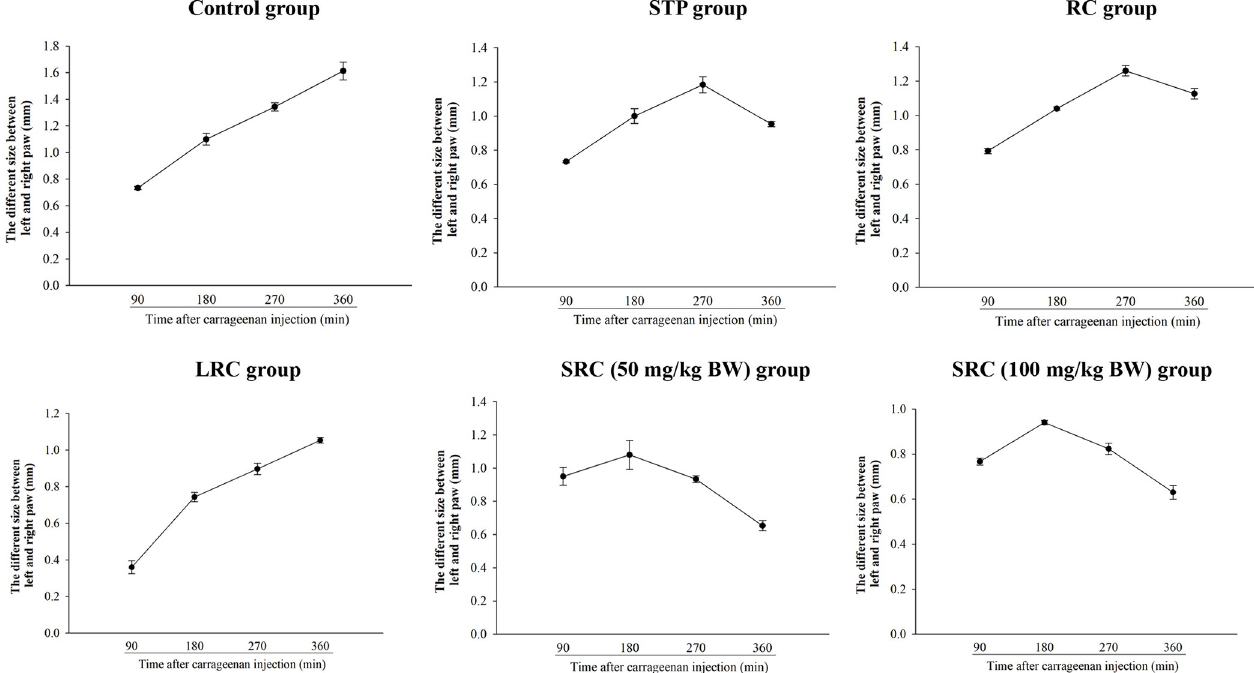
Fig 4. Effect of SRC on carrageenan-induced paw edema. The results are presented as the mean ± SD ( n = 5). STP = strawberry powder, RC = rice cake, LRC = L-glutamine rice cake, and SRC = strawberry rice cake.